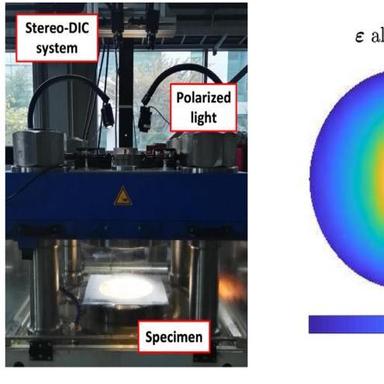
Hydraulic bulge test machine with DIC set-up (a). Logarithmic strain fields along the RD and TD directions (b).